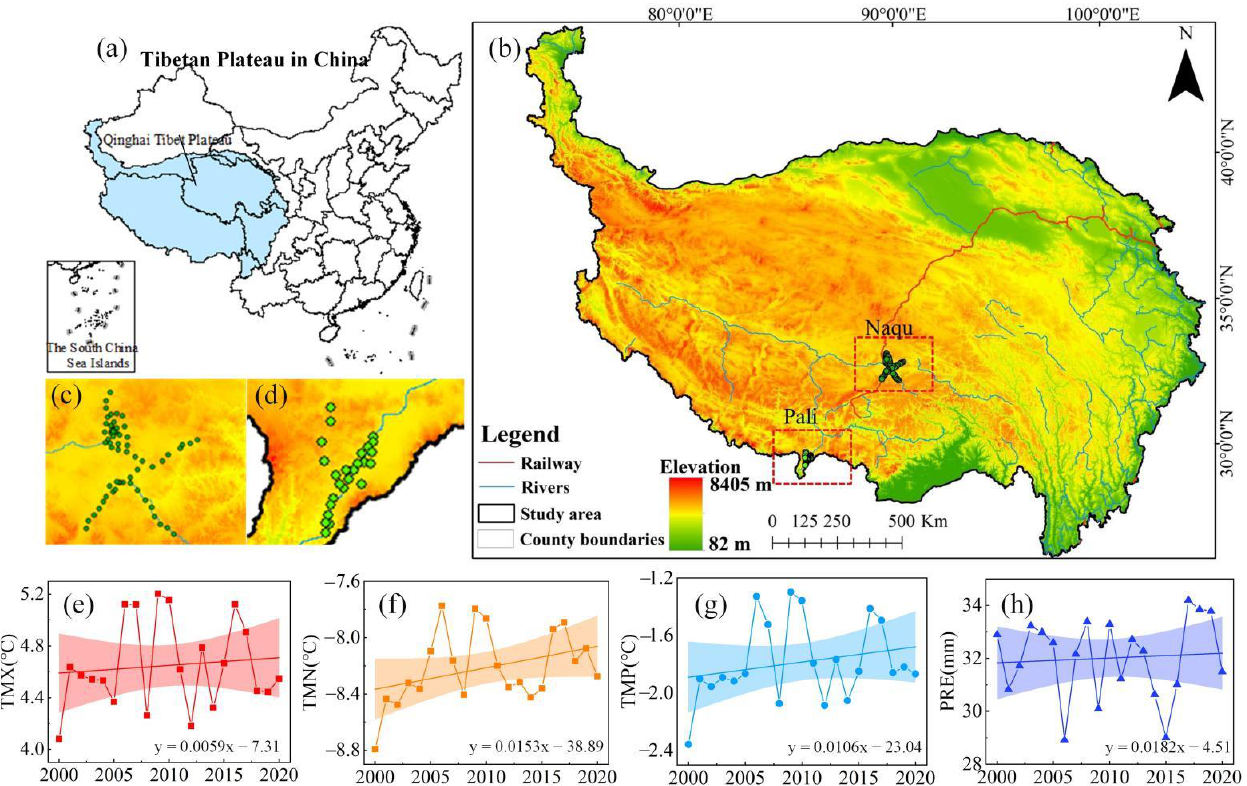
Figure 1. Map of the study area and its climatic conditions and location of the observation sites on the TP: ( a ) location of the TP in China, ( b ) map of the TP, ( c ) Naqu network, ( d ) Pali network, ( e ) high temperature, ( f ) low temperature. ( g ) mean temperature, ( h ) precipitation.